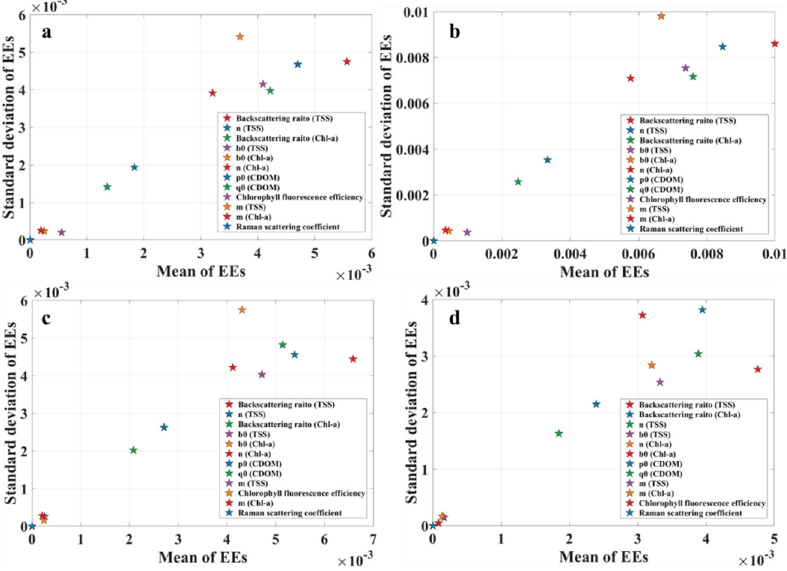
Figure 4. Sensitivity analysis results for the HN region—( a ) is the parameter sensitivity result at the water surface level; EE indicates the elemental effect values calculated by the model output differences from the parameter change; ( b ) is the sensitivity result at the subsurface; ( c ) is the sensitivity result at a depth of 0.5 m; and ( d ) is the sensitivity results at a depth of 1.0 m. Table 2. Sensitivity parameter ranking.